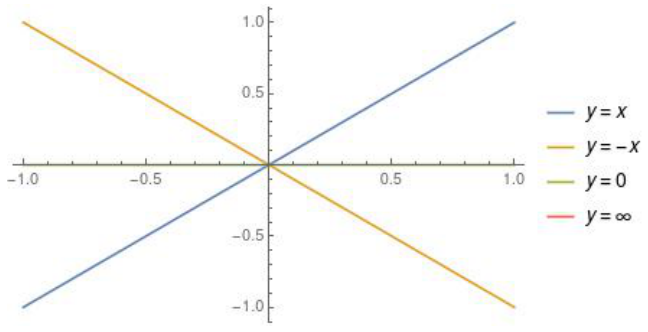
Figure 1. Eigenvectors in Example